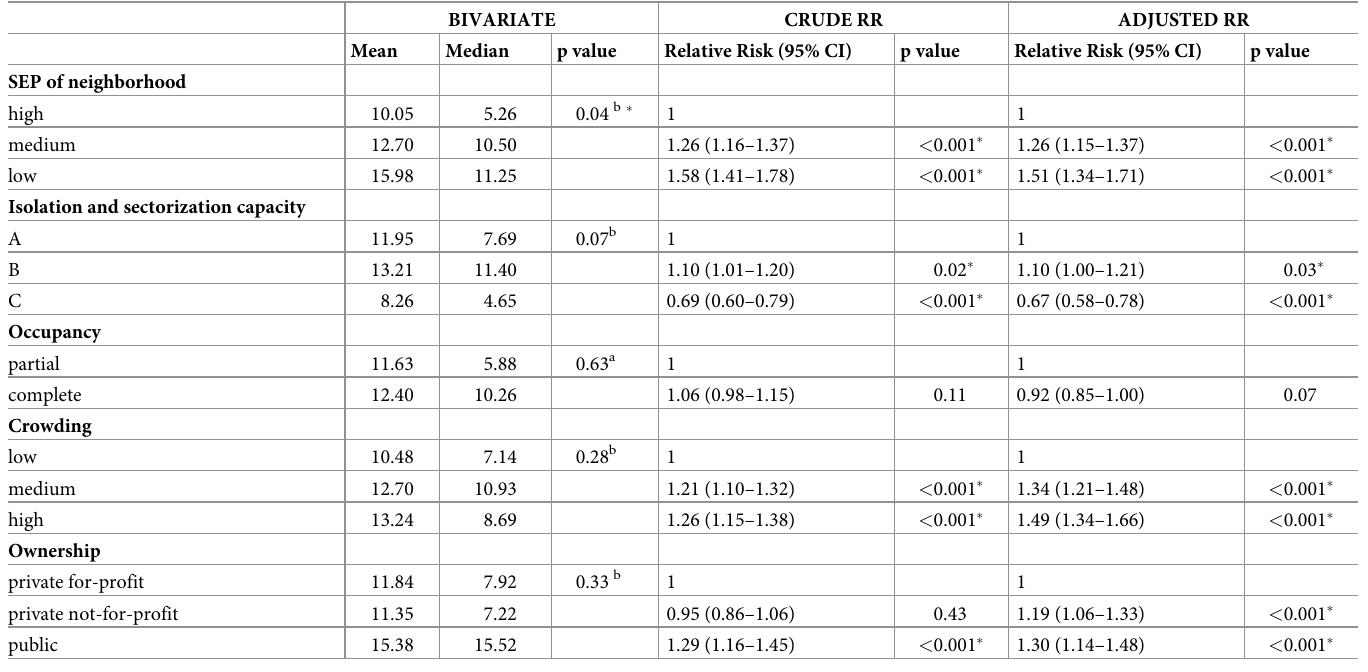
Table 2. Mortality rate of nursing homes according to socioeconomic and structural variables in the period from March to June 2020 in Barcelona